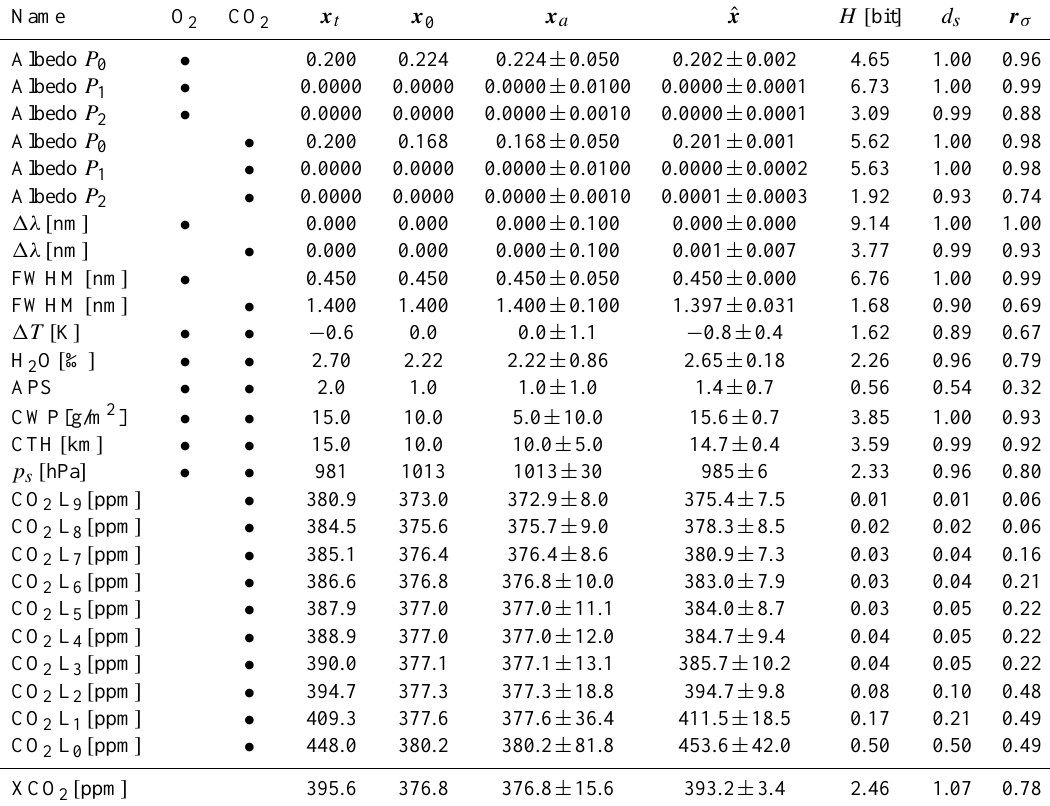
Table 3. Detailed retrieval results of the “met. 1 σ ” scenario for each state vector element and for the resulting XCO 2 . The meaning of the columns from left to right is: 1) name of the state vector element, 2+3) weighting function with non-zero elements in the O 2 and CO 2 fit window, respectively, 4) true state x t , 5) first guess state x 0 , 6) a priori state x a ±uncertainty, 7) retrieved state ˆ x ±stochastic error, 8) information content H , 9) degree of freedom for signal d s , 10) uncertainty reduction r σ Note: x t , x 0 , x a , ˆ x , and the corresponding errors are rounded to the same number of digits within each